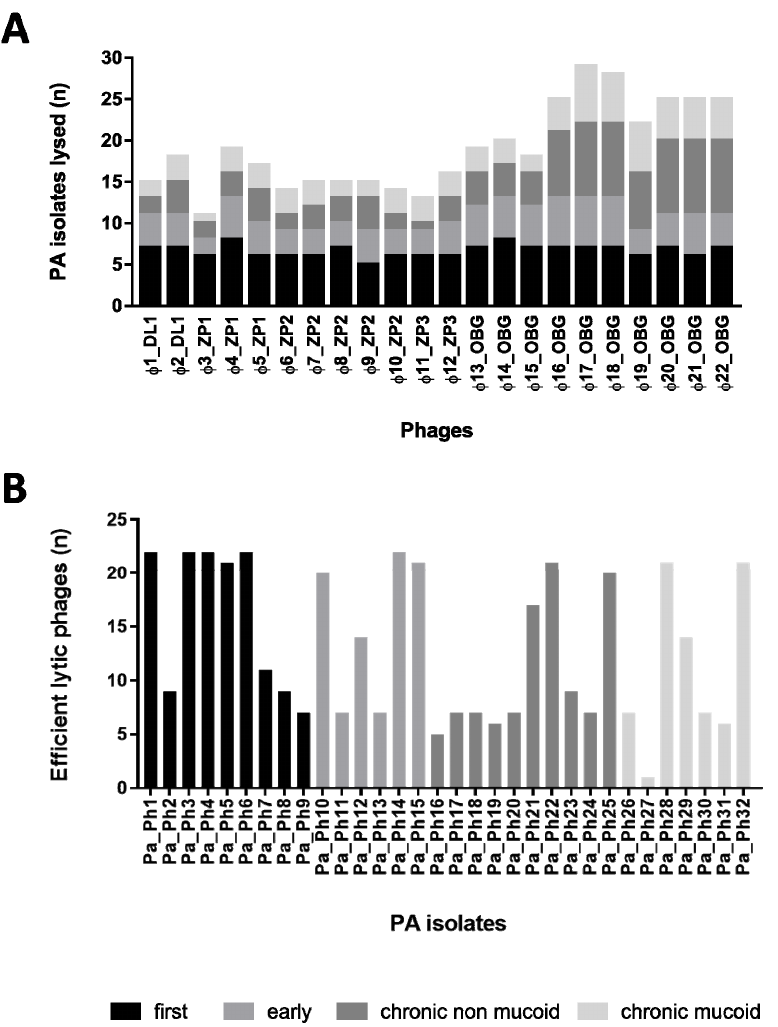
Figure 2. Phage cross activities (lytic abilities) of the 22 newly isolated phages against 32 Pseudomonas aeruginosa (PA) isolates (Pa_Ph1–Pa_Ph32) from patients with cystic fibrosis (CF); ( n ) = numbers. Phages are stratified in ( A ), and CF PA isolates in ( B ) according to the various lung infection stages: Black for first infection (i.e., CF PA isolated right after the first infection); light grey, early infection (i.e., early CF PA isolated one year after the first infection); grey, chronic non-mucoid CF PA isolates, and very light grey, chronic mucoid CF PA isolates (i.e., chronic CF PA isolated for at least five years after first infection). Overall, whereas all the newly isolated environmental phages showed the same lytic activity against several first CF PA infections, phages ( Φ 16_- Φ 22_OBG) isolated from